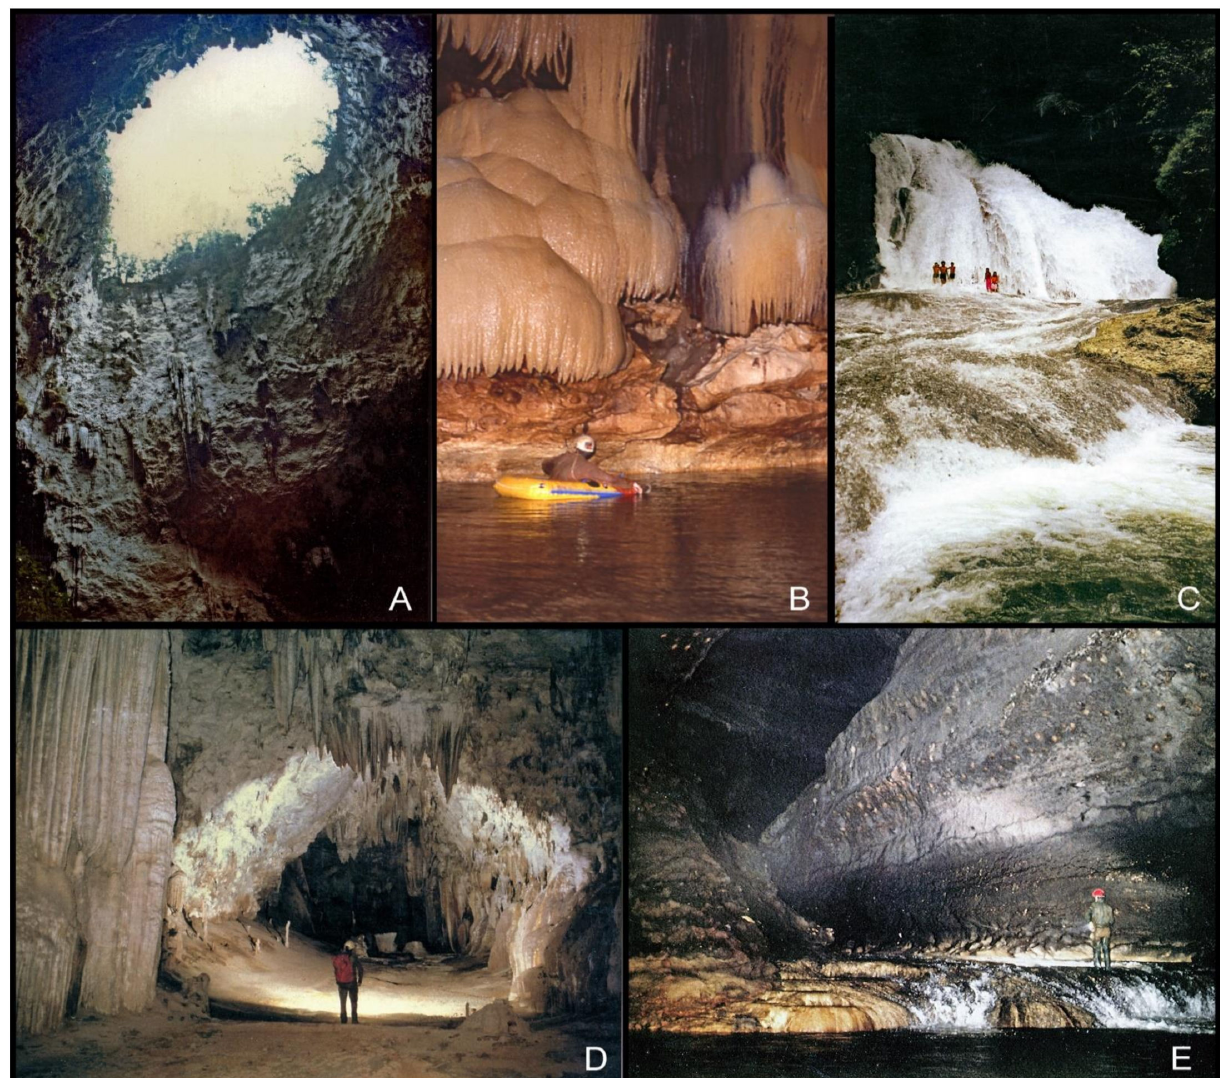
Figure 2. ( A ) Lubang Leaputte; ( B ) Gua Salukkan Kallang underground river; ( C ) Bantimurung waterfall, downstream Towakkalak spring; ( D ) Fossil gallery in Gua Tanette; ( E ) underground river in Gua Tanette. Reproduced with permission from Didier